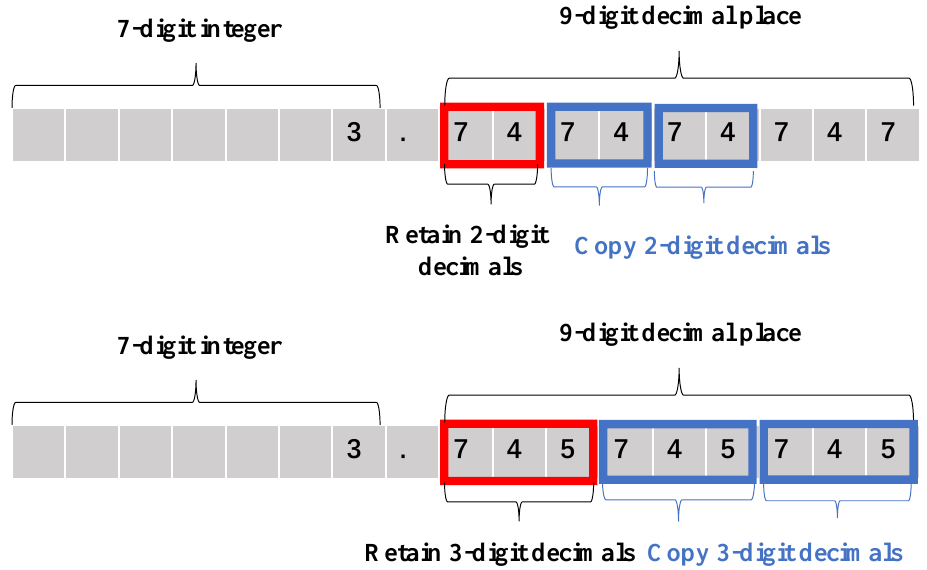
Figure 4. Examples of decimal replication method.